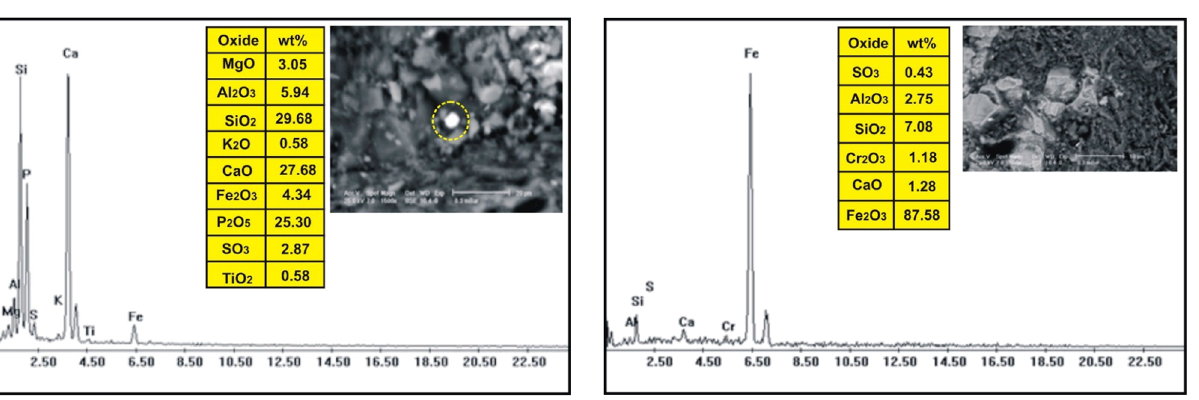
Figure 14: ESEM - EDX analysis of apatite in basalt dike at Wadi Geba. Figure 16: ESEM - EDX analysis of magnetite in dolerite dike at Wadi Geba.